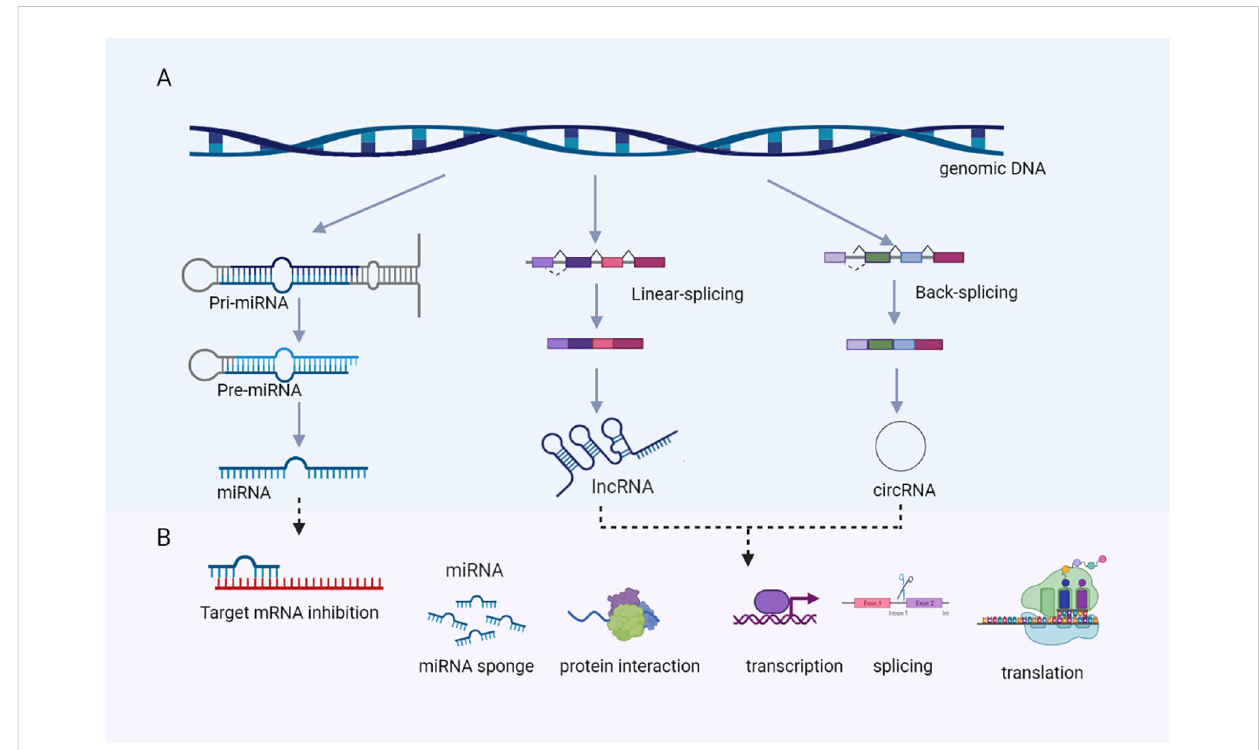
FIGURE 2 Genesis (A) and biological functions (B) of ncRNAs, including miRNA, lncRNA, and circRNA. Figures are created in